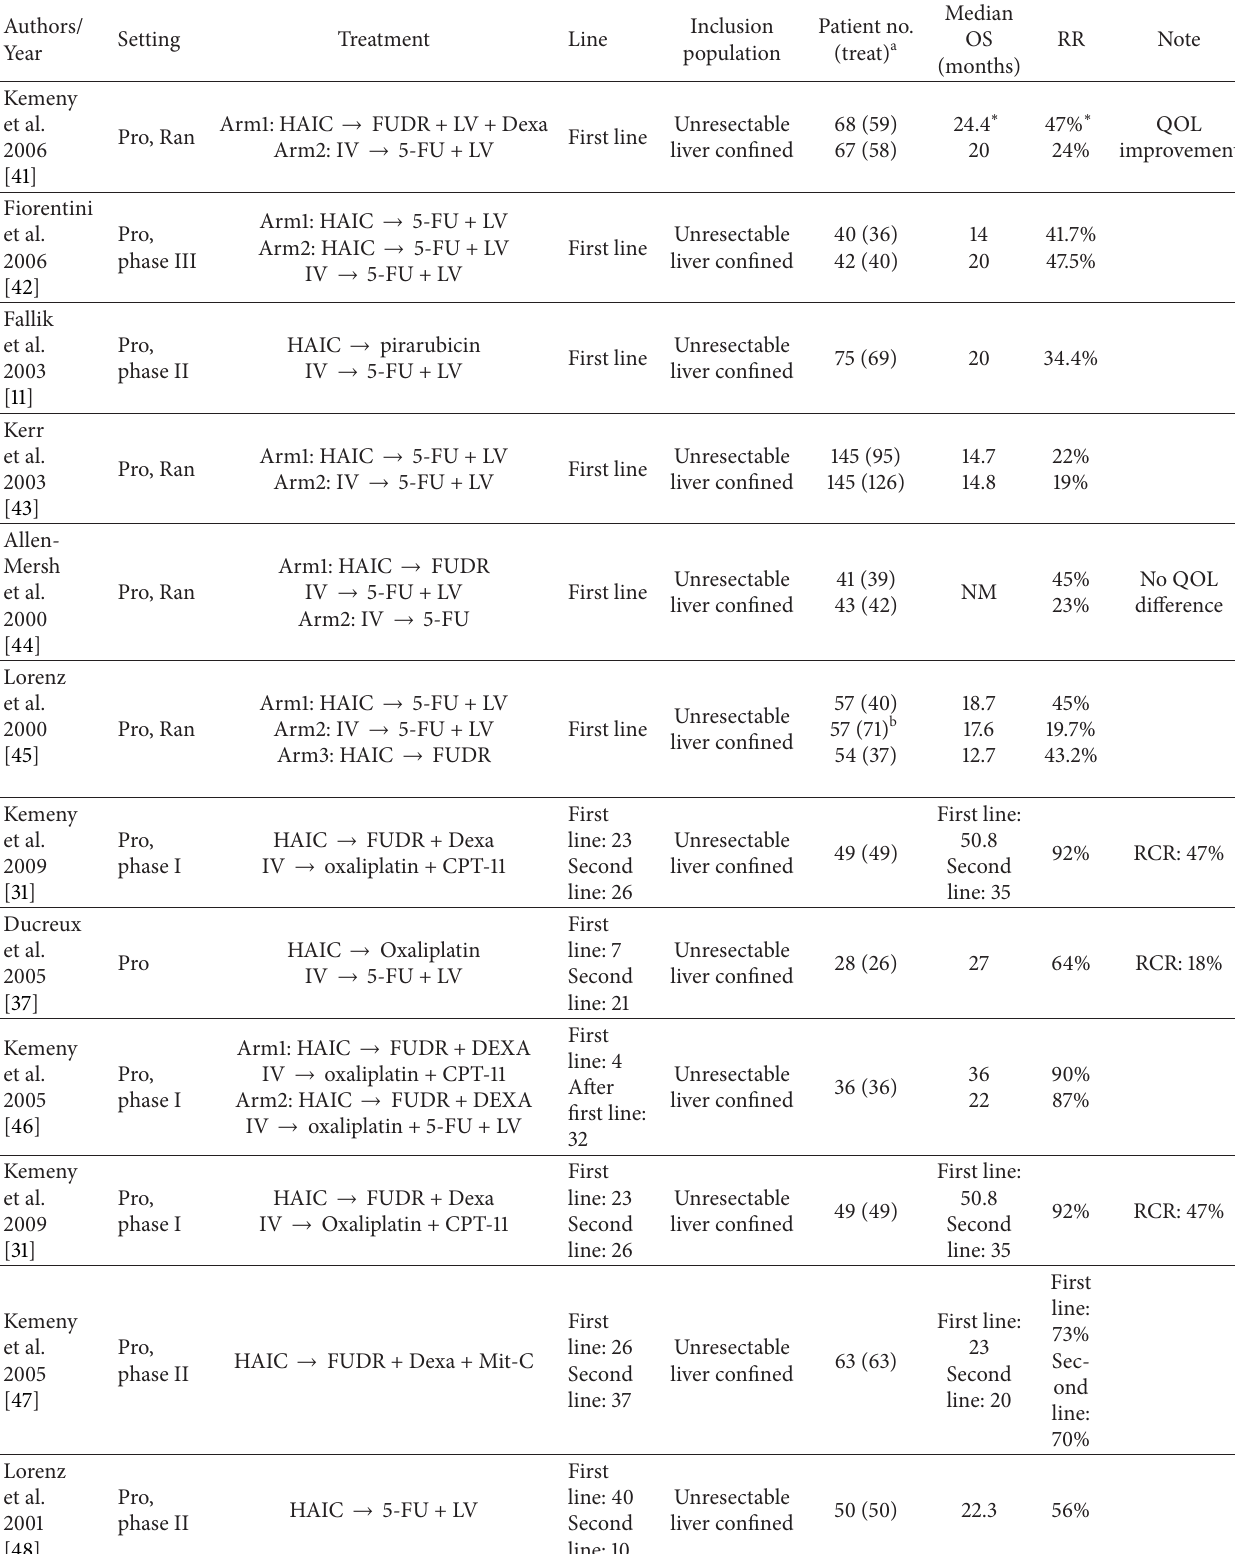
Table 2: Selective studies of HAIC for liver-confined metastatic disease from colorectal